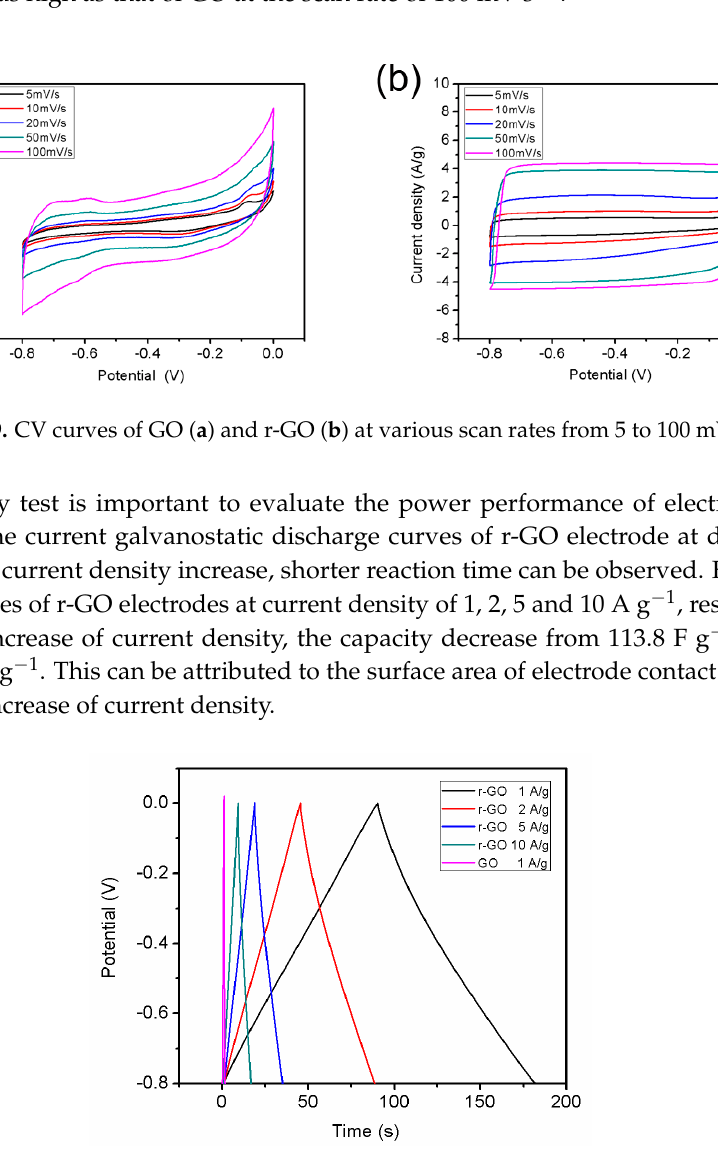
Figure 10. Galvanostatic charge–discharge curves of the symmetric supercapacitor at various current densities in 2 M KOH.